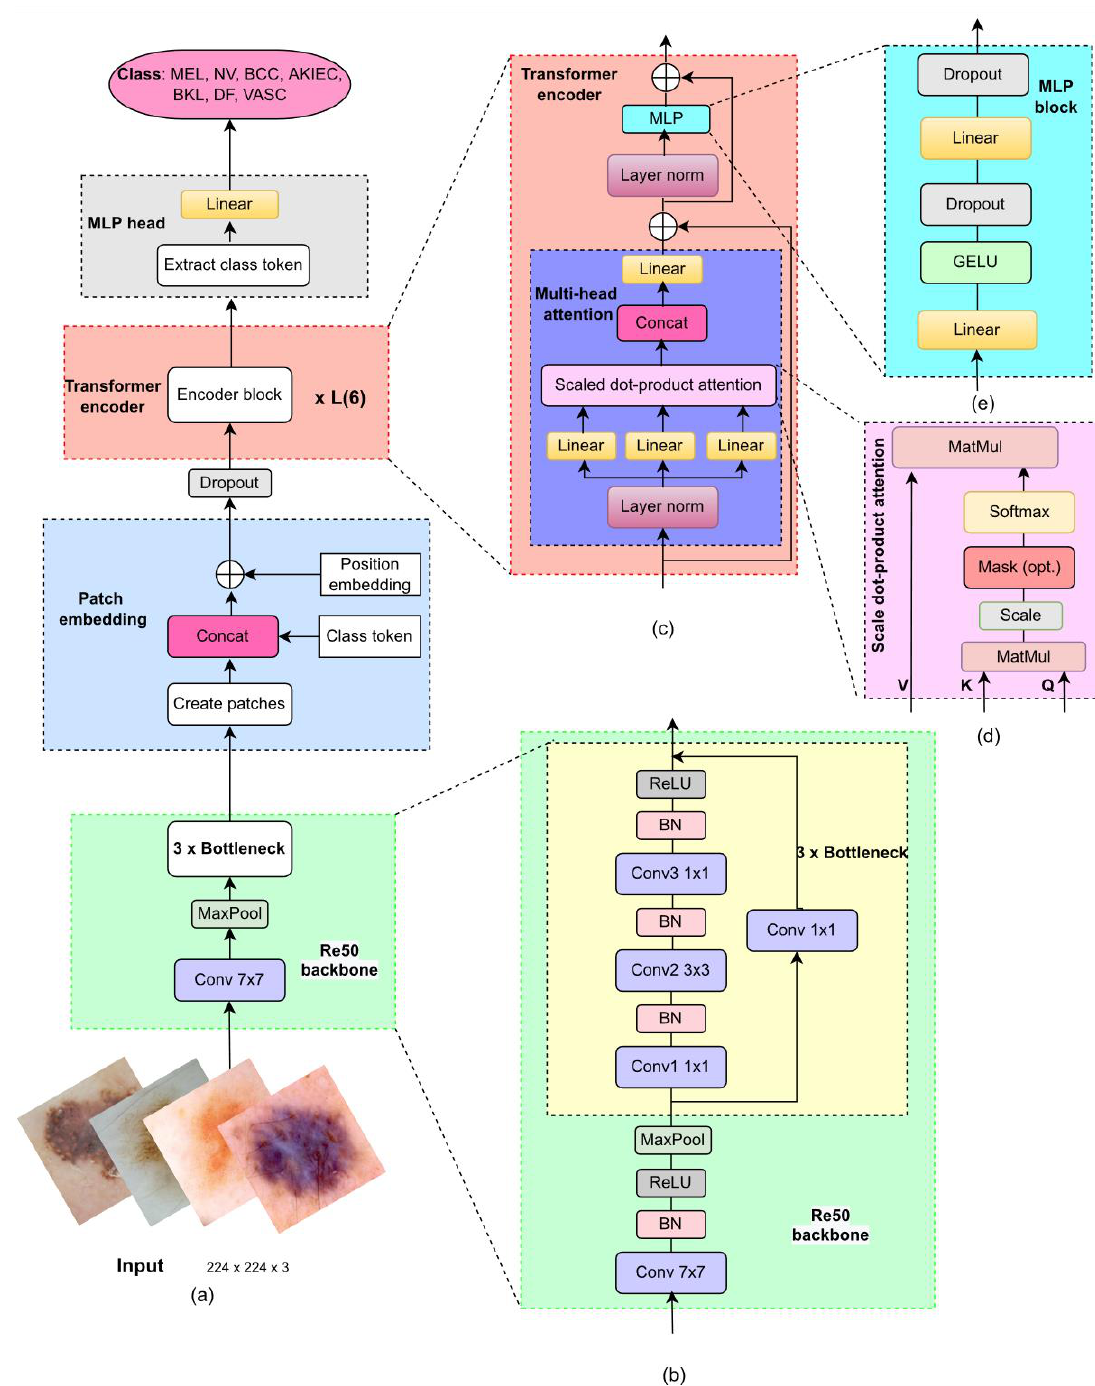
Figure 2. Overview of the proposed hybrid architecture: ( a ) The model comprises two main parts: the convolutional neural network (CNN) and the vision transformer (ViT); ( b ) the CNN for feature map generation; ( c ) the transformer encoder; ( d ) scaled dot product attention; and ( e ) multi-layer perceptron (MLP). The ViT works on global attention encoding for the MLP head classification. GELU = Gaussian error linear